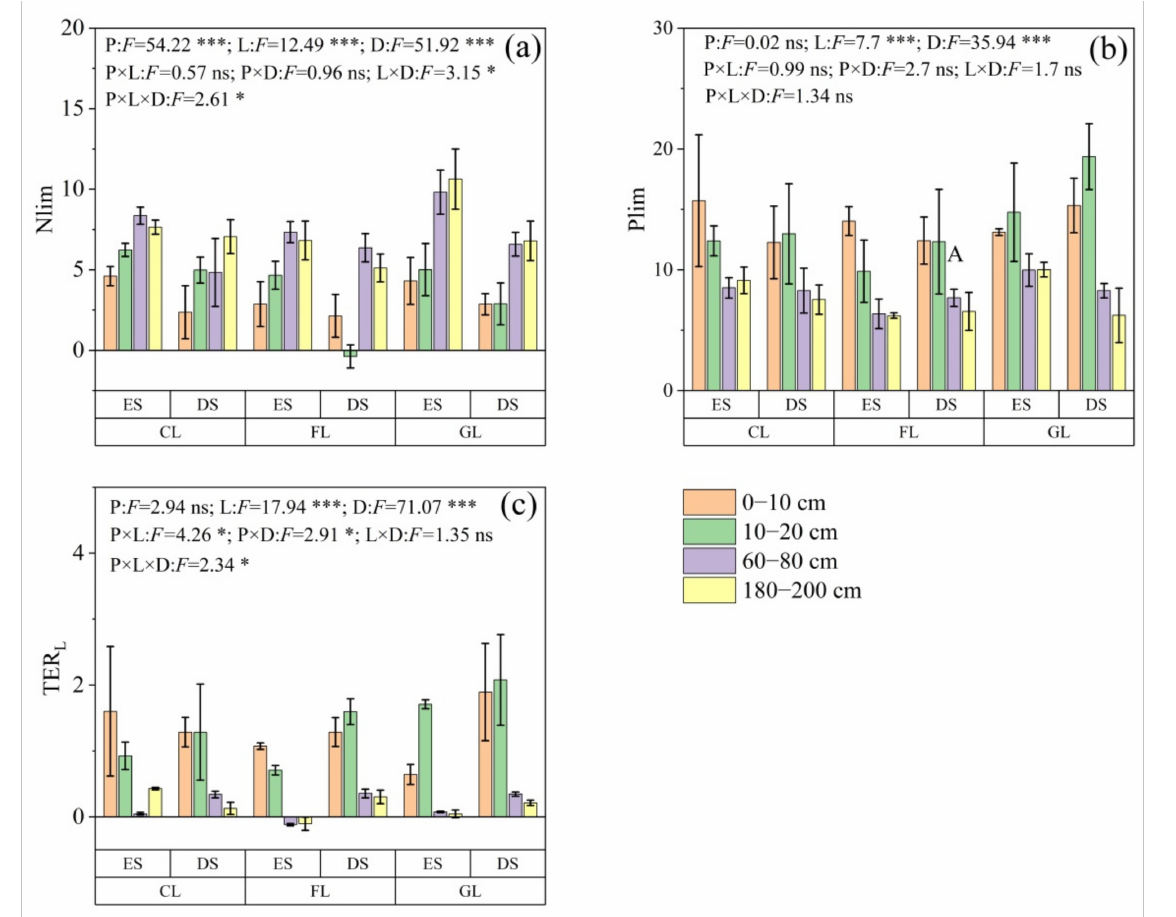
Figure 3. ( a ) Microbial N limitation, ( b ) microbial P limitation and ( c ) Threshold elemental ratio (TER L) from different soil sites. CL: cropland; FL: forestland; GL: grassland; ES: eroded site; DS: deposited site. Different capital letters represent significant difference ( p < 0.05) between different landform positions in the same land use type and soil depth. Values are expressed as the mean ± standard error. P: landform position; L: land use type; D: soil depth. ***, * mean the significant differences at p < 0.001 and p < 0.05, respectively, and ns means no significant differences ( p >